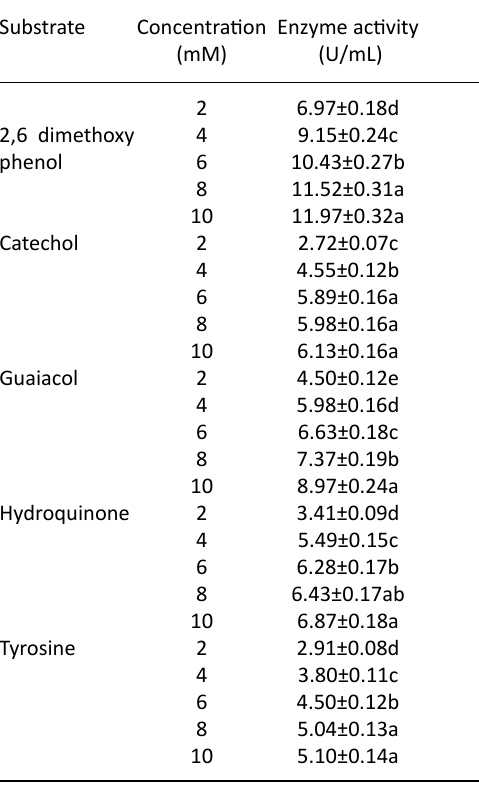
Table 4. Affinity of the purified SSF laccase towards various substrates with different